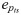
The proposed algorithm and BayClone.(a), (b) and (c): Plots of the genotype error (eZ), proportion error (eW) and error of success probability (epts) versus different sample sizes for the proposed algorithm and BayClone.